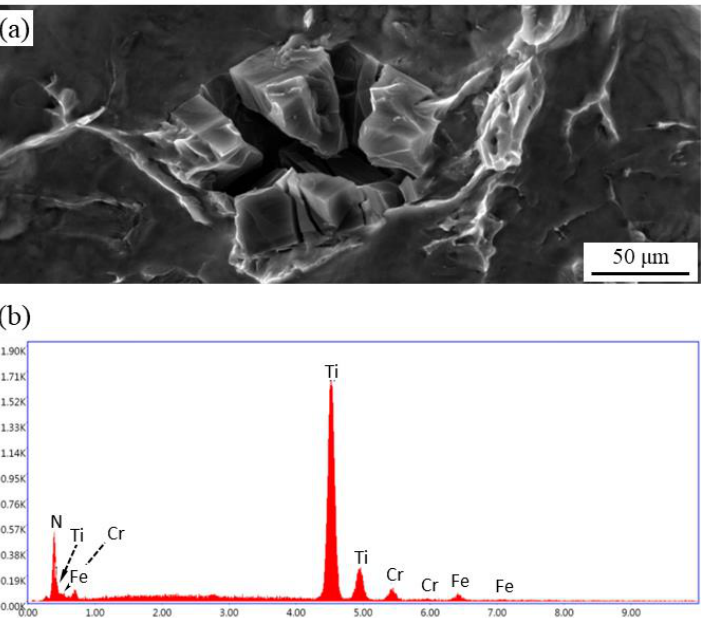
Figure 10. EDX analysis of Ti-based nonmetallic inclusion in UNS S32205 reinforcement after failure immersed in carbonated solution (CBS, pH 9.1) contaminated with 8 wt.% Cl – : ( a ) SEM micrograph × 7600, and ( b ) EDX spectrum.